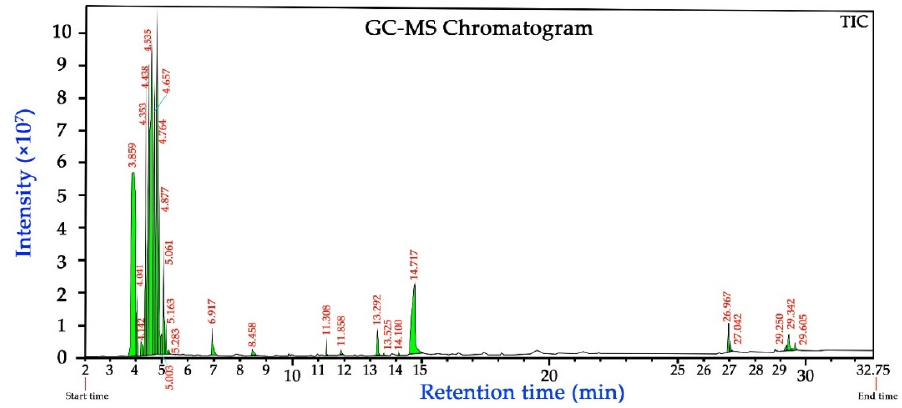
Figure 7. GC–MS chromatogram of methanolic extract of pomegranate peel. Table 6 represents the identified components of the GC-chromatogram based on different retention times and mass spectral patterns using the NIST107 and WILEY229 Mass Spectral Library database of known compounds stored in the GC–MS library. A total of 28 compounds were detected, out of which the major compounds identified as hexane (42.2%), methanol (18.09%), 2,3-dimethylpentane (10.13%), heptane (6.64%), hydroxymethyl furfurol (HMF) (6.05%), methyl-cyclopentane (5.33%), cyclohexane (3.89%), and ethanol (1.57%). The 9,12-octadecadienoic acid and n-hexadecanoic acid are characteristic secondary metabolites found in many plants have been shown to possess several biological properties, such as antimicrobial and anti-inflammatory hypocholesterolemic, cancer preventive, hepatoprotective, and antioxidants [70]. Table 6. GC–MS characterization of the phytochemical components of pomegranate ( Punica granatum L., Rabab-e-Neiriz cultivar) peel extract. Peak